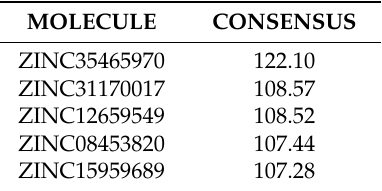
Figure 6. Distribution of compounds according to their affinity energy against MtKasA. Table 3. Consensus ranking of variables: relationship between the result of QFIT and Grid + Hawkins GB/SA for MtbKasA.